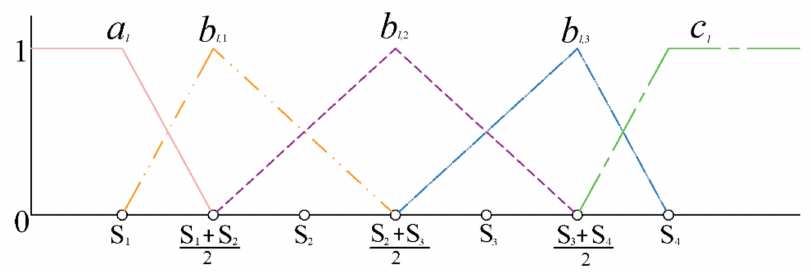
Figure 4. The sketch map of the degree of connection in set pair analysis